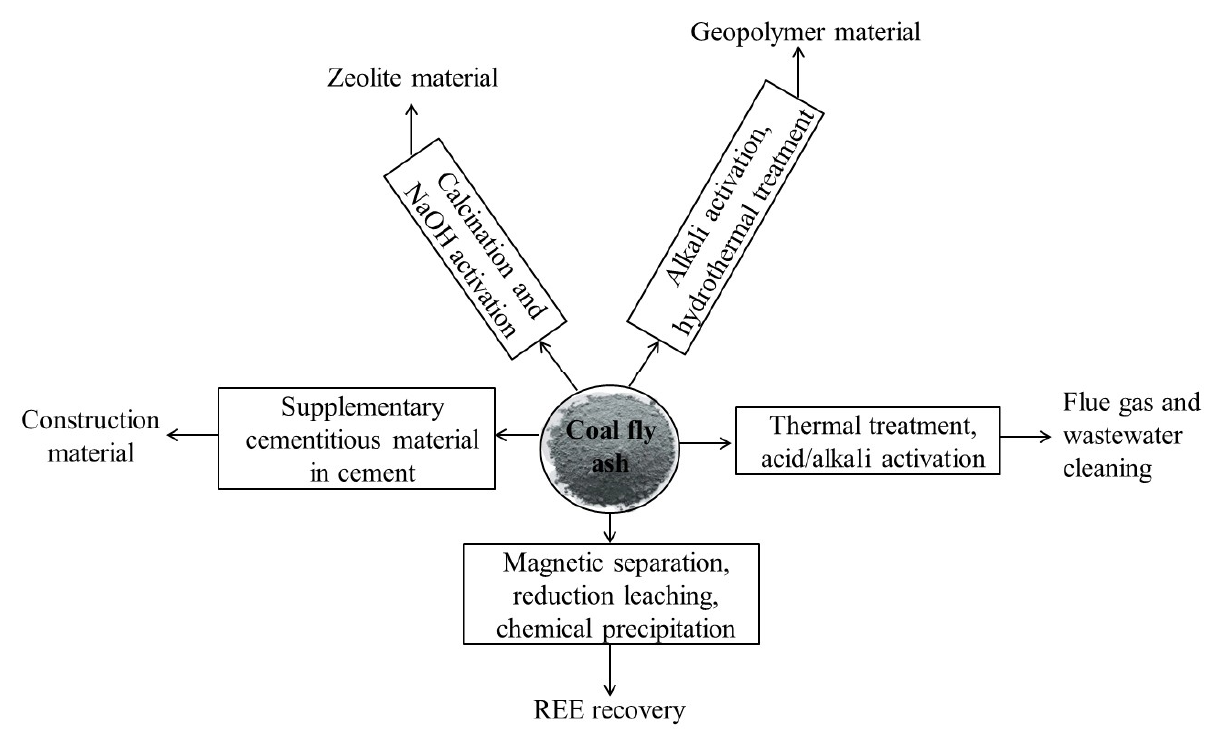
Figure 10. Various treatment routes to recirculate the fly ash from waste stream to different end applications.